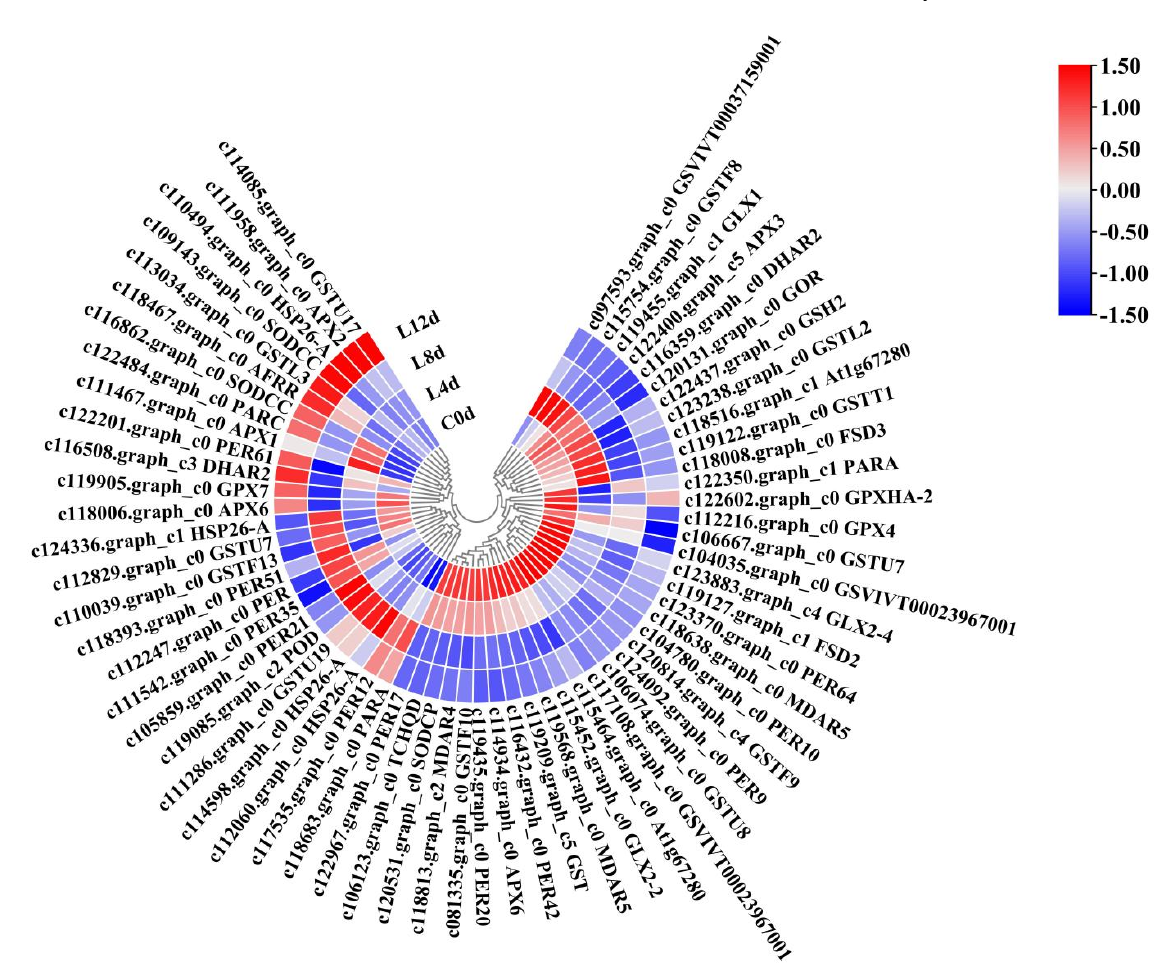
Figure 8. Heatmap of the antioxidant system ‐ related DEGs in response to low ‐ temperature in litchi. ‘Huaizhi’ litchi trees were grown in a chamber with 22 °C/17 °C (day/night temperature, 12 h day and 12 h night) as the normal temperature. Temperatures dropped from the normal one to 2 °C for 4 d, and then were maintained at 2 °C for another 8 d. C0d, L4d, L8d, and L12d mean leaves samples at 0 d, 4 d, 8 d, and 12 d of treatment. Fragments per kilobase of transcript per million mapped reads (FPKM) values were normalized to Z ‐ score.